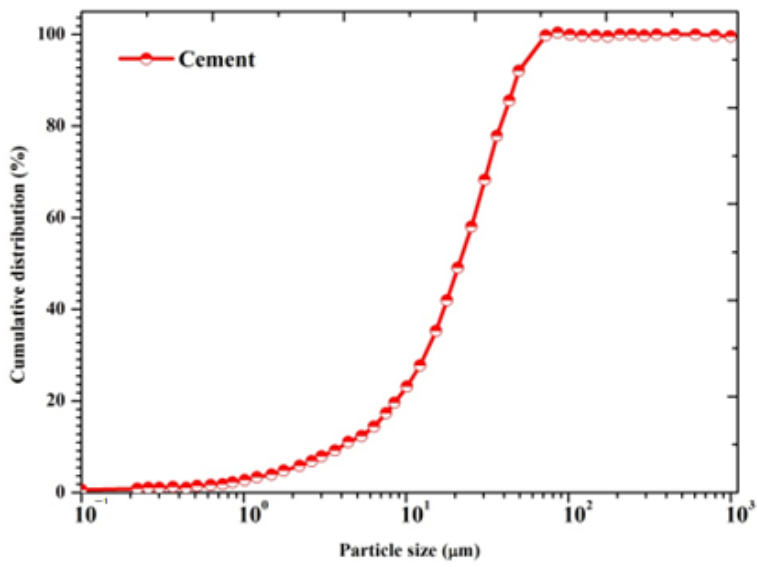
Figure 1. Particle size distribution of OPC.